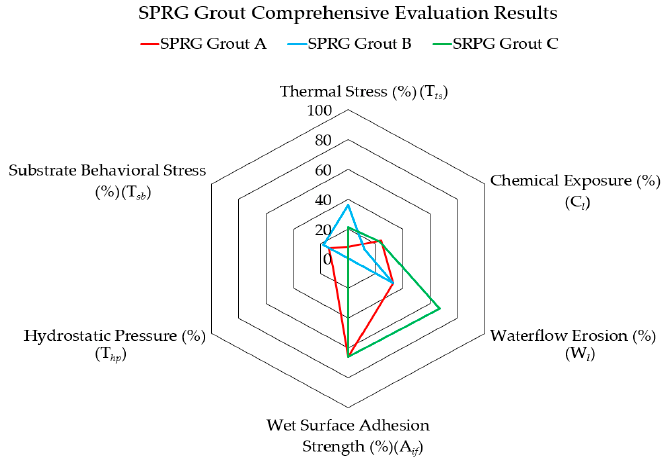
Figure 16. The physical properties change of the SPRG grout-injection material.